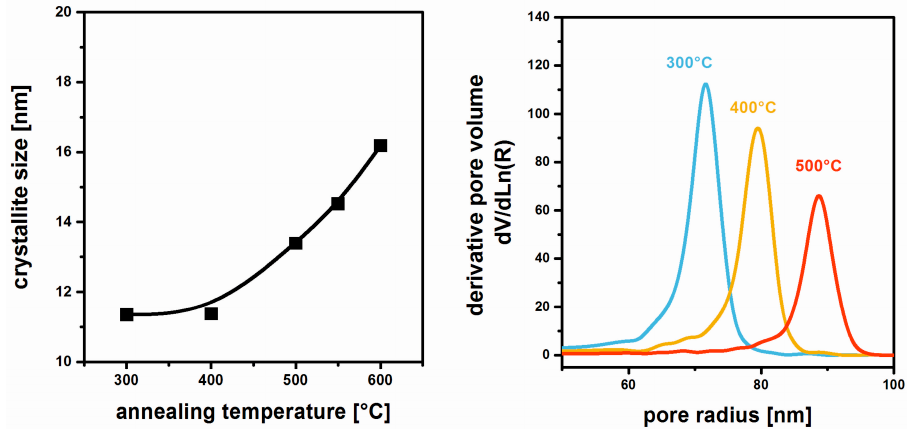
Figure 7. Crystallite size derived from XRD data ( left ) and pore radius distributions as determined by Ellipsometric Porosimetry ( right ) of MgF 2 films annealed at different temperatures. Reproduced with permission from [42]. Copyright The Royal Society of Chemistry, 2012.